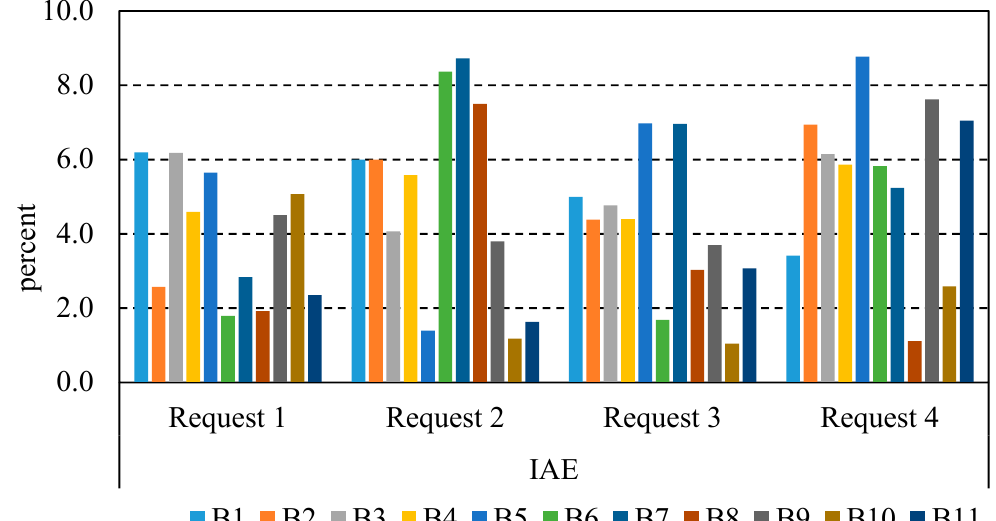
Figure 9. The maximum absolute error (MAE) performance indicator in the East Aghili Canal.